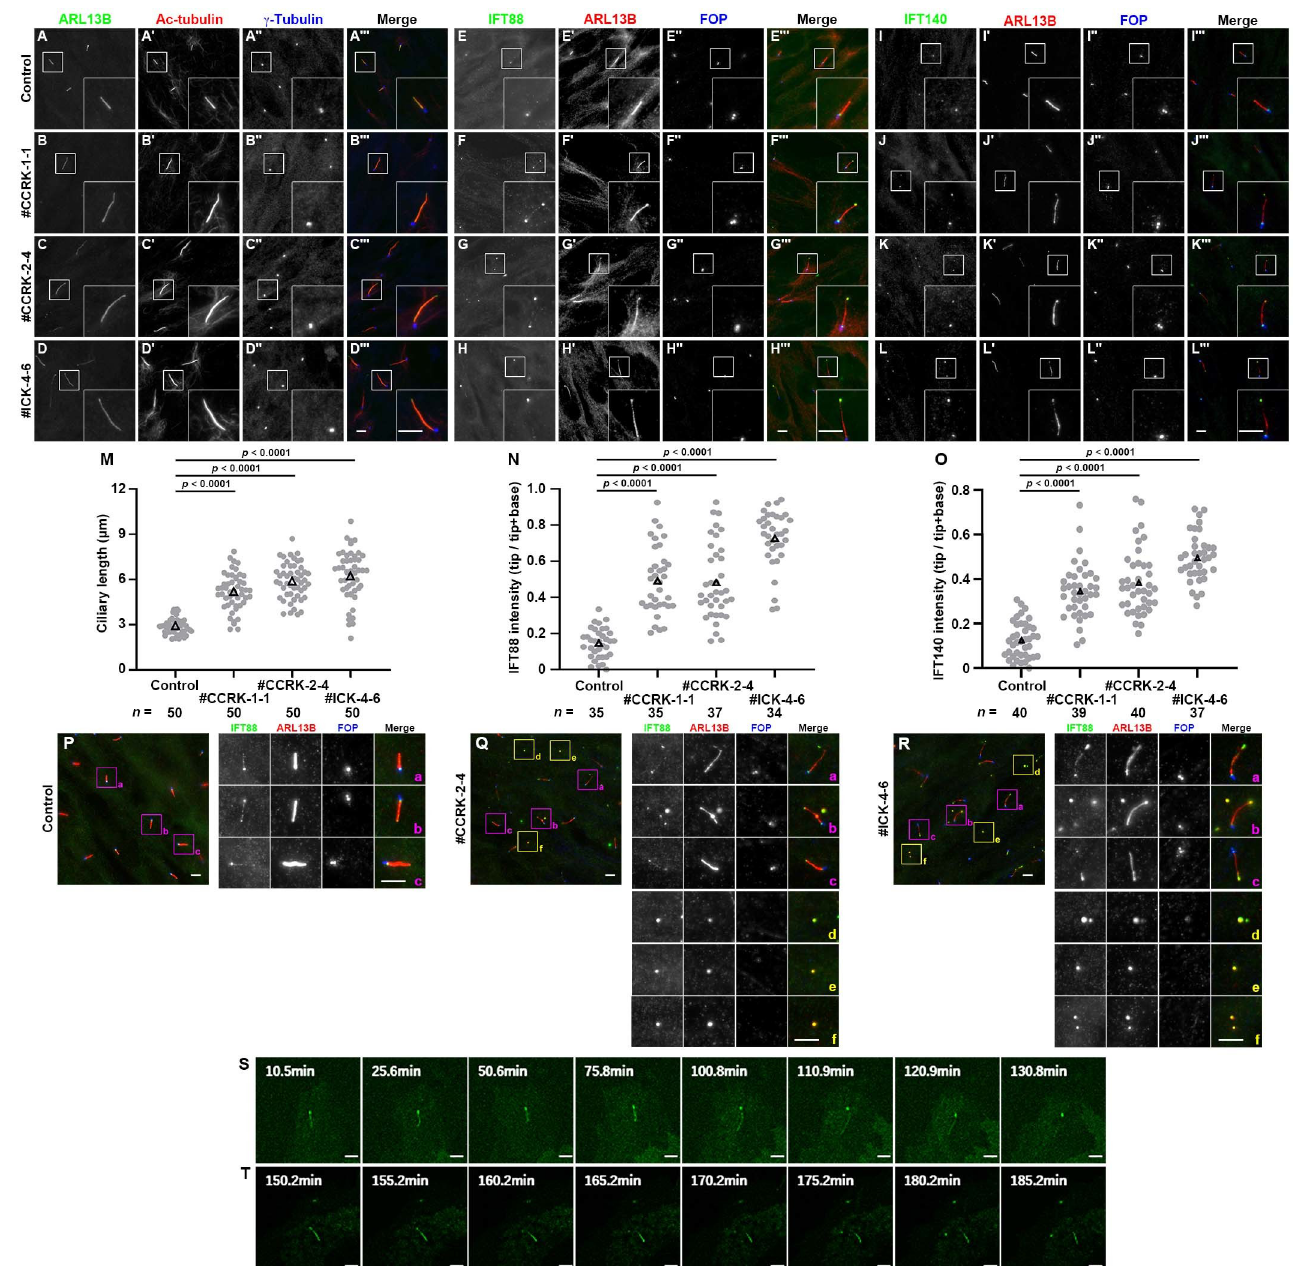
Fig 2. Cilia elongation and the accumulation of IFT proteins at the ciliary tips of CCRK -KO cells. (A–L) Control RPE1 cells (A, E, I), the CCRK -KO cell lines #CCRK-1-1 (B, F, J) and #CCRK-2-4 (C, G, K), and the ICK -KO cell line #ICK-4-6 (D, H, L) were serum-starved for 24 h to induce ciliogenesis, and triple immunostained for ARL13B, Ac-tubulin, and γ -tubulin (A–D), IFT88, ARL13B, and FOP (E–H), or IFT140, ARL13B, and FOP (I–L). Scale bars, 5 μ m. (M) Ciliary lengths of the cells shown in (A)–(D) were measured and expressed as scatter plots. (N, O) Relative staining intensities of IFT88 and IFT140 at the ciliary tips and base in the cells shown in (E)–(H) and (I)–(L), respectively, were estimated, and the intensity ratios of tip/(tip+ base) were expressed as scatter plots. The triangles indicate the means. Statistical significances were calculated using one-way ANOVA followed by the Dunnett’s multiple comparison test. (P–R) Control RPE1 cells (P), the CCRK -KO cell line #CCRK-2-4 (Q), and the ICK -KO cell line #ICK-4-6 (R) were triple immunostained for IFT88, ARL13B, and FOP as described above. The boxed regions labeled a–f were 2.5-fold magnified and shown at the right. (S, T) The release of ECVs from the ciliary tips of the CCRK -KO cell line #CCRK-2-4 stably expressing ARL13B( Δ GD)-EGFP. Time-lapse images of S1 and S2 Videos are shown. Scale bars, 5 μ m.